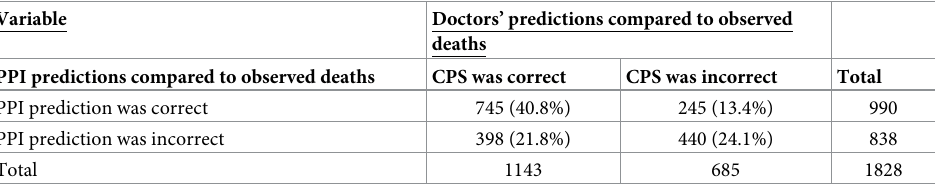
Table 4. Comparison between accuracy of PPI predictions versus accuracy of